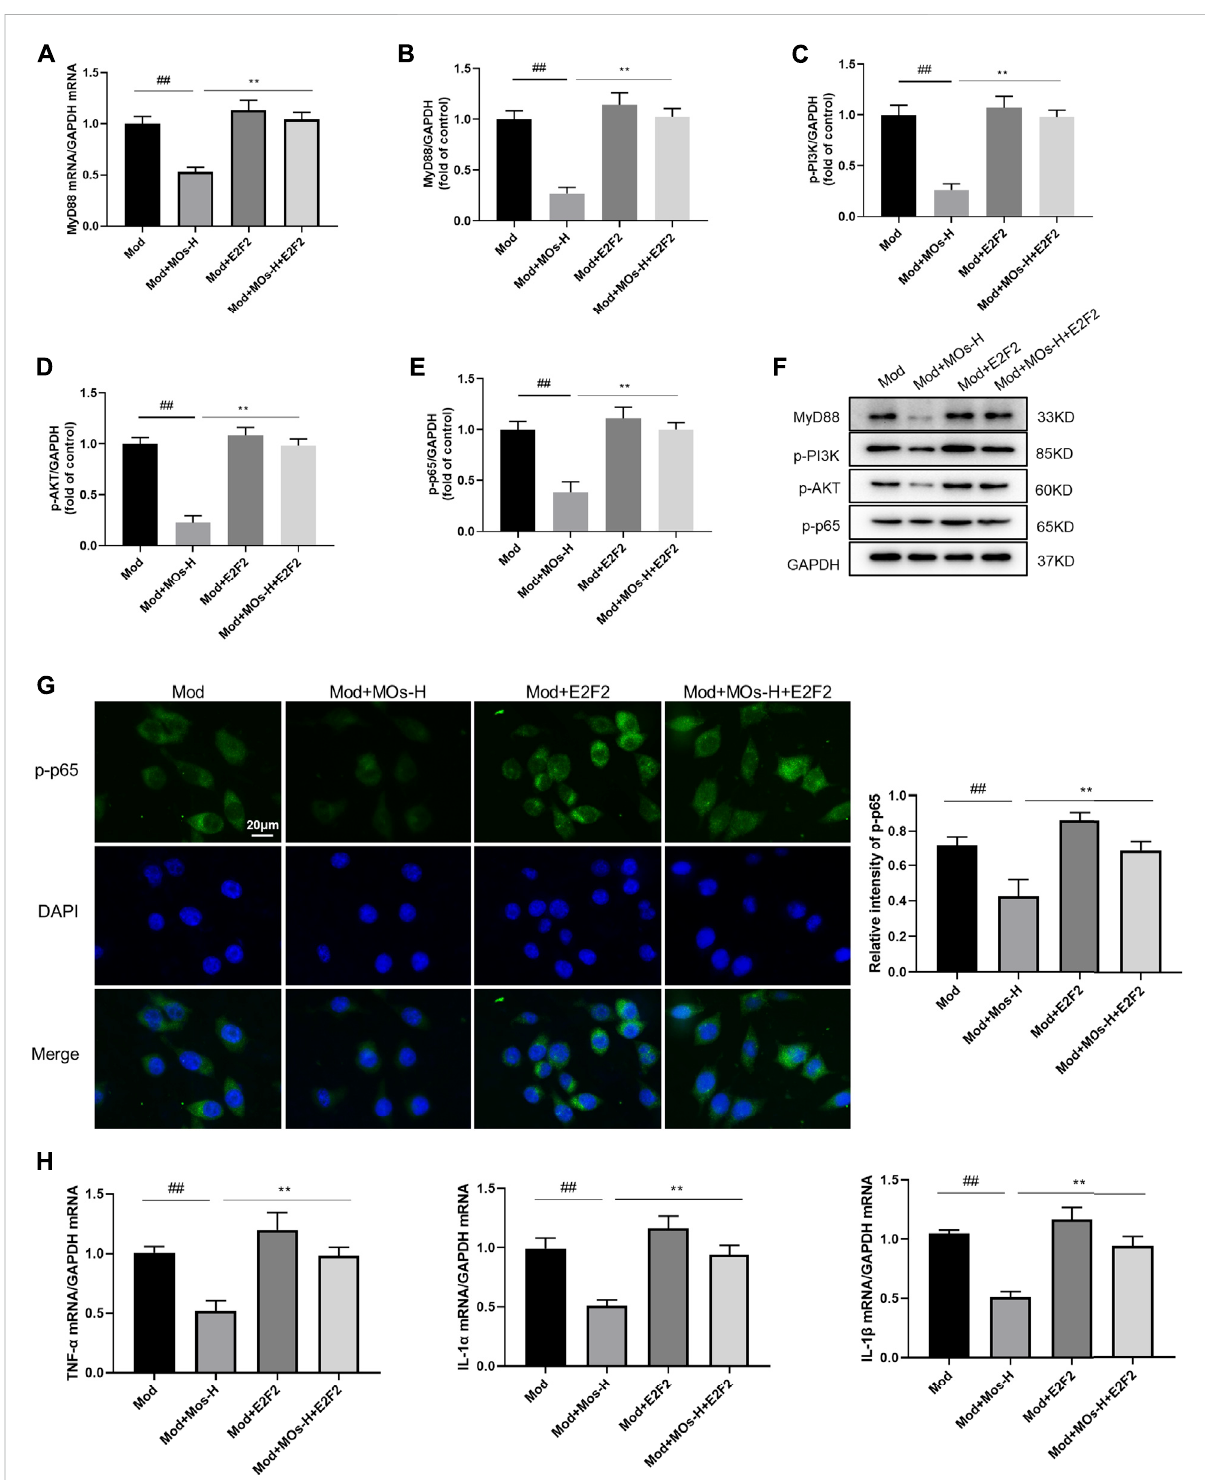
FIGURE 8 Effects of MOs in LPS- and ATP-stimulated BV2 cells were reversed by overexpression of E2F2. (A) qRT-PCR analysis of MyD88 mRNA expression in BV2 cells. (B – F) Immunoblot analysis of MyD88, p-PI3K, p-AKT and p-NF- κ B p65 in BV2 cells. (G) Representative hippocampus immuno fl uorescentstainingforp-NF- κ Bp65(green)andnuclei(blue),andquanti fi cationofrelativeexpressionofp-NF- κ Bp65. (H) TNF- α ,IL-1 α and IL-1 β mRNA levels in BV2 cells. Data are expressed as means ± SD ( n = 3). ## p < 0.01; ** p <